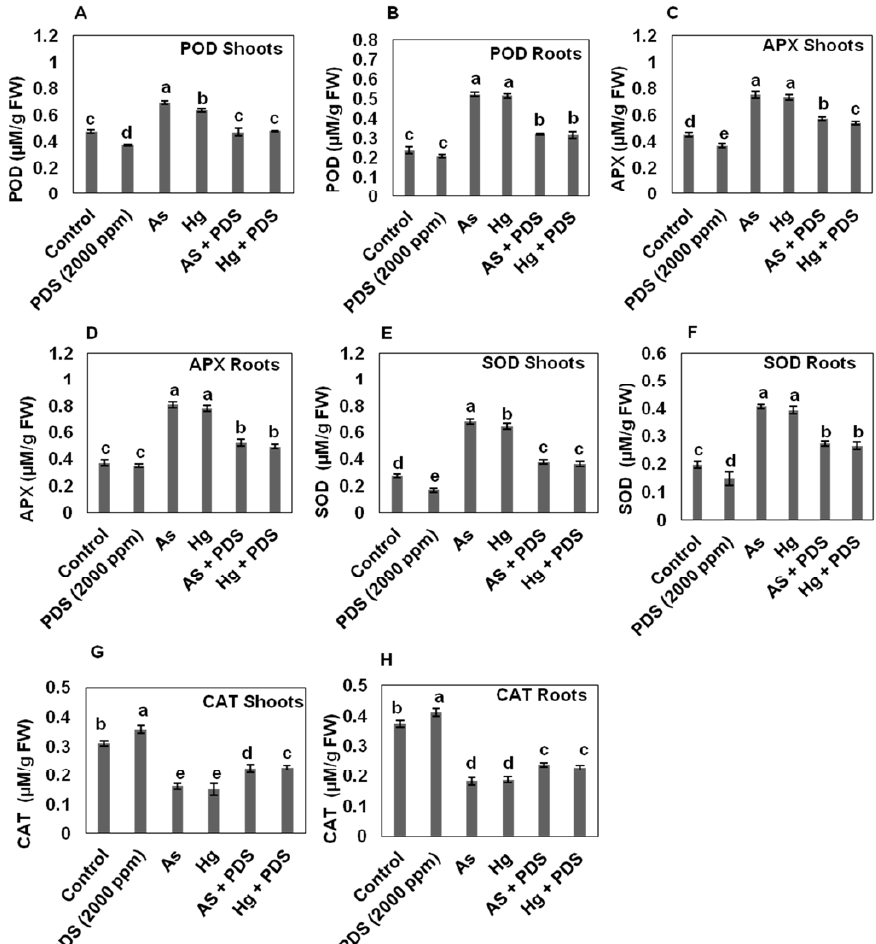
Figure 5. Evaluation of antioxidant enzymatic activity under PDS, As and Hg-treated wheat seedlings. Graphical bars ( A , B ) show POD in shoot and root, ( C , D ) show APX in shoot and root, ( E , F ) SOD and ( G , H ) CAT. Wheat seeds were treated with PDS (2000 ppm), As, Hg, PDS + AS and PDS + Hg. 7-day-old seedlings of wheat were harvested. Three randomly selected seedlings from each replicate were chosen for the analysis of POD, APX, SOD and CAT activities. The activities of POD, SOD and APX were lower under PDS treatment and higher under As and Hg treatment, while the CAT activity was higher under PDS and lower under As and Hg treatment. All data were analyzed using one-way ANOVA, with multiple comparisons using the LSD test at a significance level of p ≤ 0.05 ( n = 5). The different lowercase letters represent homogeneous subsets and indicate the statistical significance according to Fisher’s